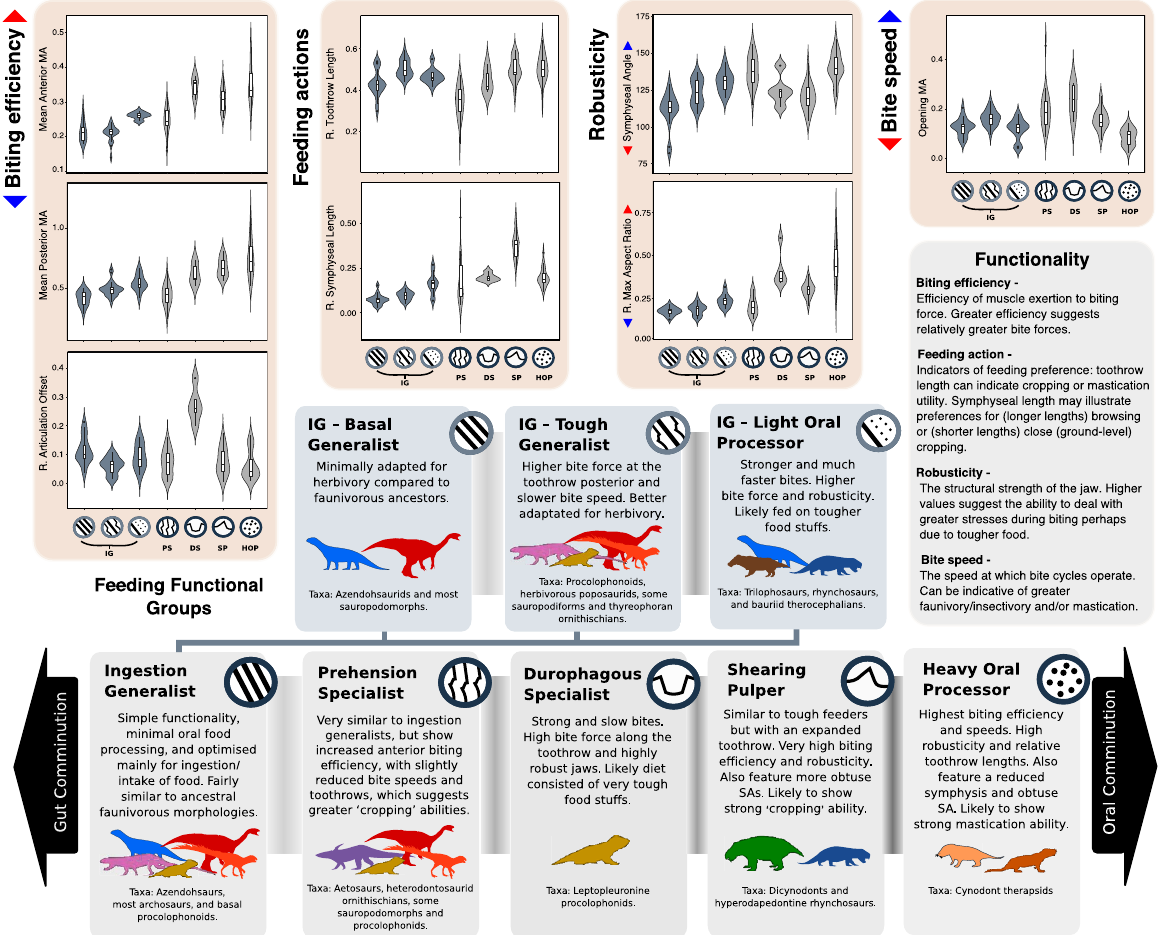
Fig. 2 Functional feeding groups. Characteristics of the different functional feeding groups with silhouettes of the taxa that exhibit these feeding modes (see Fig. 1 for silhouette key). Preference of each group for gut or oral processing/comminution of food is indicated. The strength of separation between the groups is illustrated by the darkness of the band connecting each FFG description box. Violin plots show taxon density. Box plots showing median value (centre) and upper and lower quartiles representing the minimum and maximum bounds of the boxes, with whisker illustrating standard deviation. DS durophagous specialist, HOP heavy oral processor, IG ingestion generalist, PS prehension specialist, R Relative, SP shearing pulper, SA symphyseal angle. N = 136 taxa. All silhouettes created by S.S., but some are vectorised from artwork by Felipe Alves Elias (https://www.paleozoobr.com/) and Jeff Martz (United States National Park Service), available for academic use with